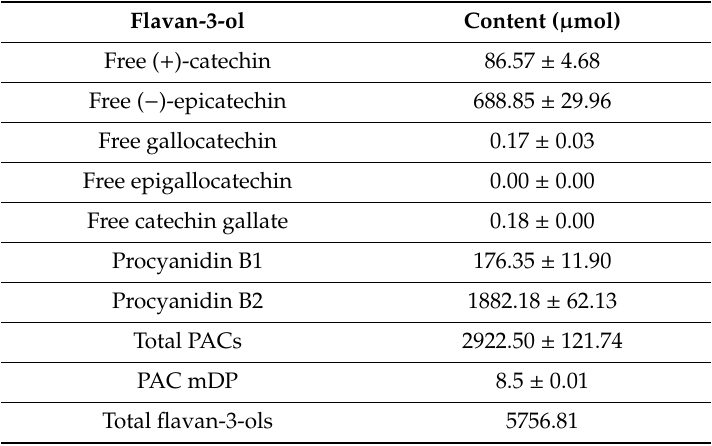
Table 1. Estimated content of monomeric flavan-3-ols and dimeric and oligomeric PAC in the apple var. Elstar ( n = 3) .